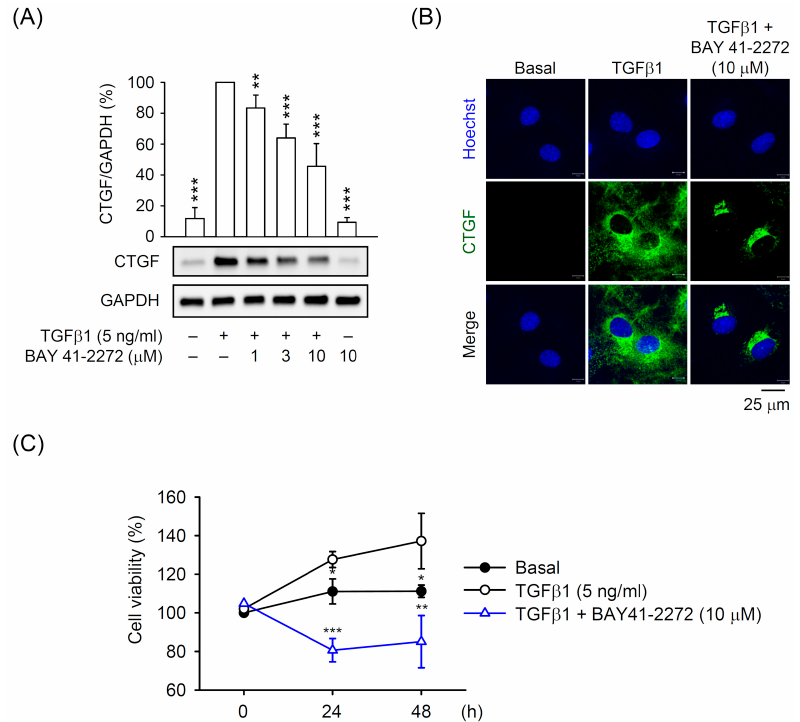
Figure 1. BAY 41-2272 repressed the transforming growth factor (TGF) β 1-induced connective tissue growth factor (CTGF) expression in hepatic stellate cells (HSCs). HSCs were preincubated with BAY 41-2272 (1–10 µ M) for 30 min before activation by TGF β 1 (5 ng / mL) for another ( A , B ) 6 h or ( C ) 24–48 h. Expression of CTGF and GAPDH was determined by ( A ) Western blot and ( B ) immunofluorescent staining using the corresponding antibodies. ( C ) Cell viability was measured using the WST-1 Assay Kit and monitored spectrophotometrically at 450 nm. All data are expressed as mean ± SD ( n = 3). * p < 0.05, ** p < 0.01, *** p < 0.001 compared with the TGF β 1 alone.